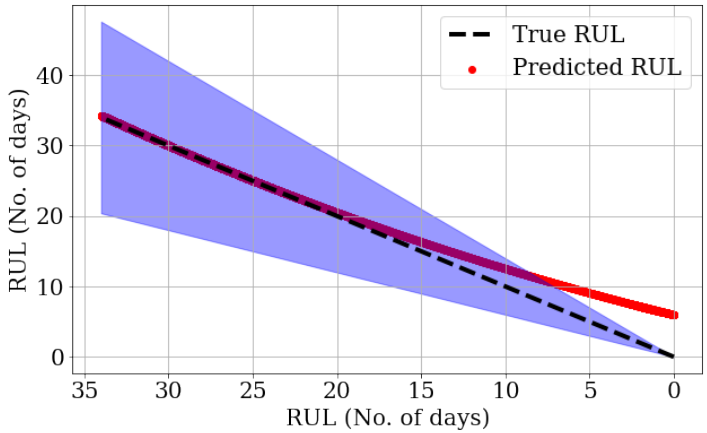
Figure 12. RUL prediction results by GRU at TSP (68th